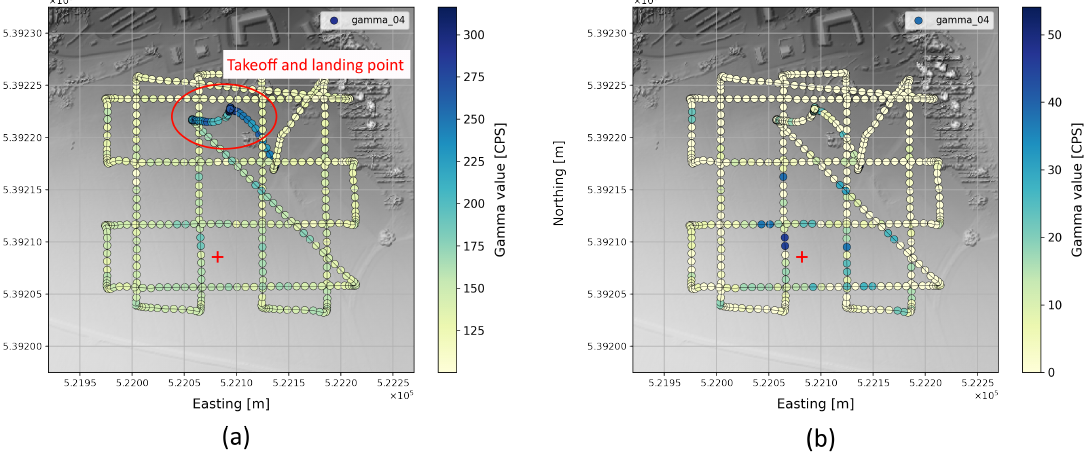
Figure 6. Application of background model. Original measurement data along the trajectory ( a ) natu- rally exhibit Poisson distributed scattering analogous to background radiation. After removal of the background radiation, only the additional radiation from radioactive sources remains ( b ). The true source position is marked with a red